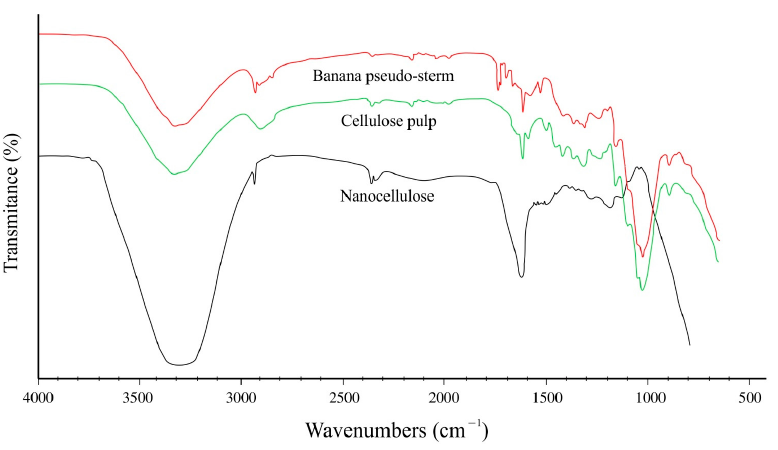
Figure 3. FT-IR spectra of nanocellulose, cellulose pulp, and banana pseudo-stem.